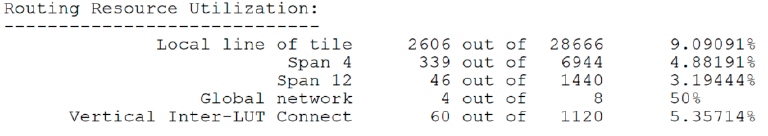
Figure 20. Routing Resource Utilization.